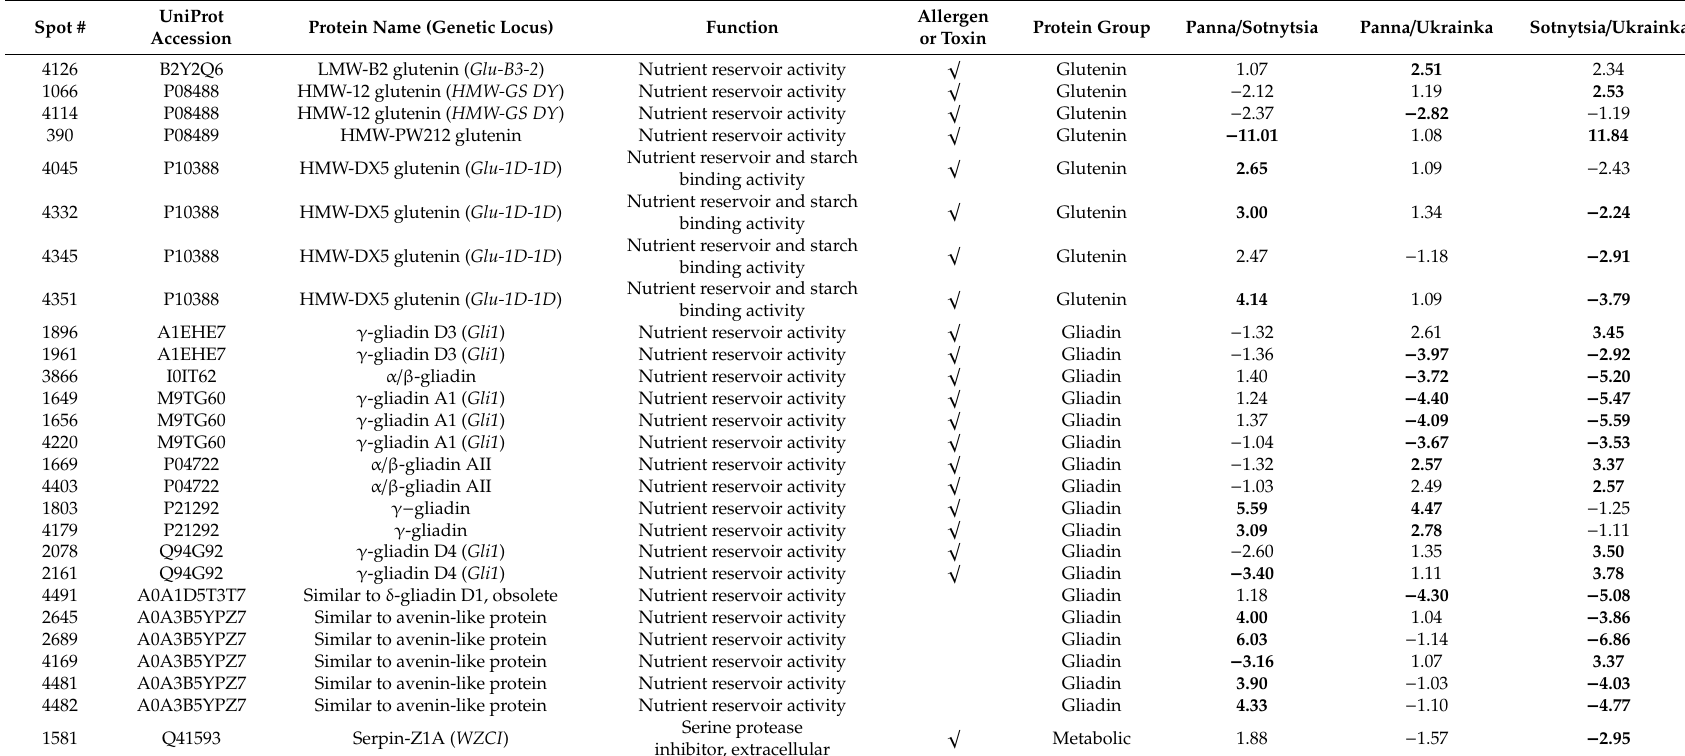
Table 1. Identified di ff erentially abundant proteins from Triticum aestivum L. cultivars discovered by two-dimensional gel electrophoresis. Bold ratios indicate significant di ff erences in the respective comparison (ratio ≥ 2.5 and Tukey’s test p ≤ 0.01). Positive value of proportion—protein is more abundant, negative value—protein is less abundant, NA—not